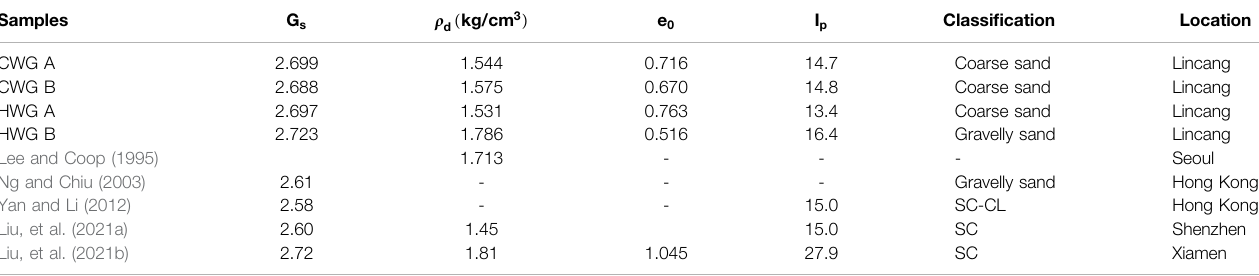
TABLE 3 | Basic physical properties and mechanical indices of weathered granites (Date from Lee and Coop (1995); Ng and Chiu (2003); Yan and Li (2012); Liu P. et al. (2021); Liu X. et al. (2021)) Samples